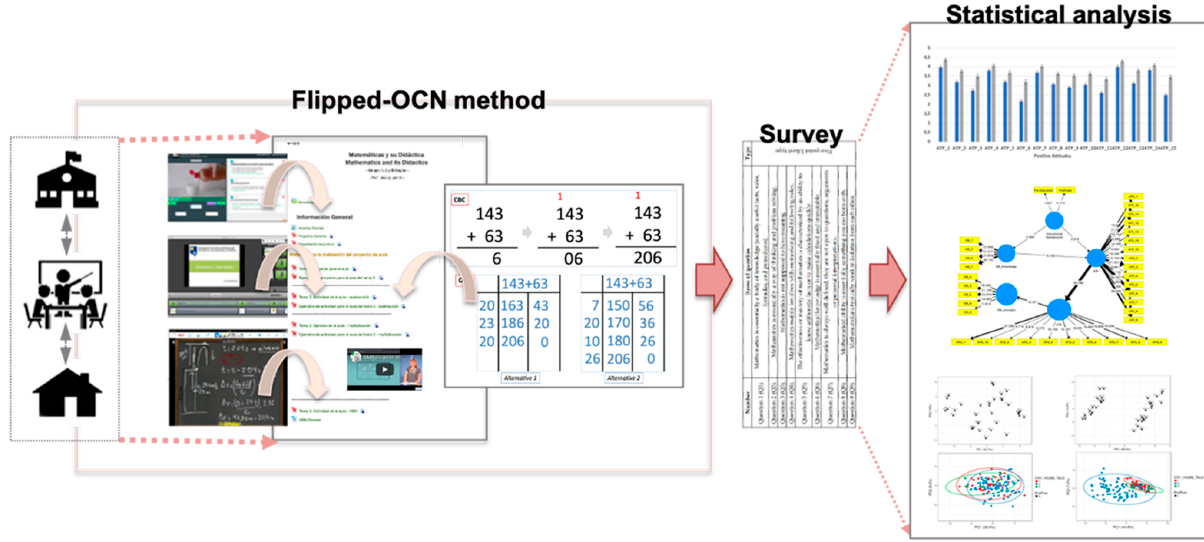
Figure 1. Research flowchart to examine pre-service teachers’ (PSTs) attitudes toward mathematics learning with the flipped- open calculation based on numbers (OCN) method.